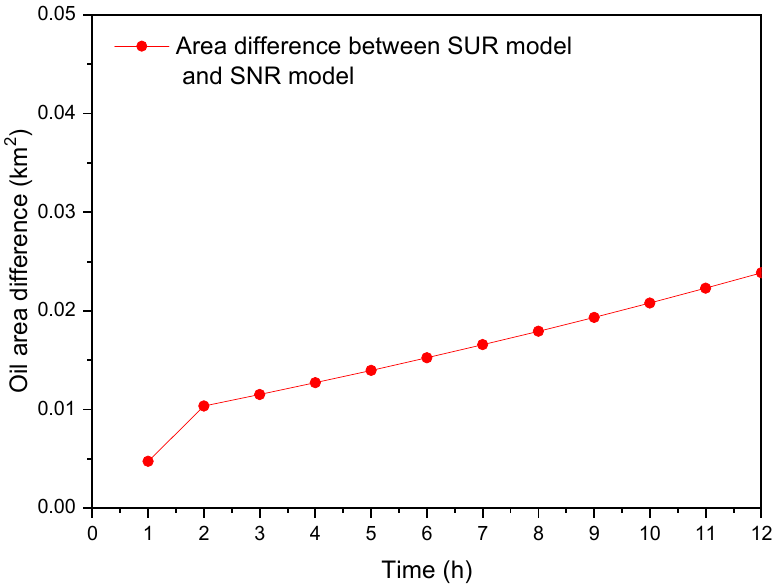
Figure 5. Area comparison between the SUR model and the SNR model; the difference in effect reflecting thickness distribution.